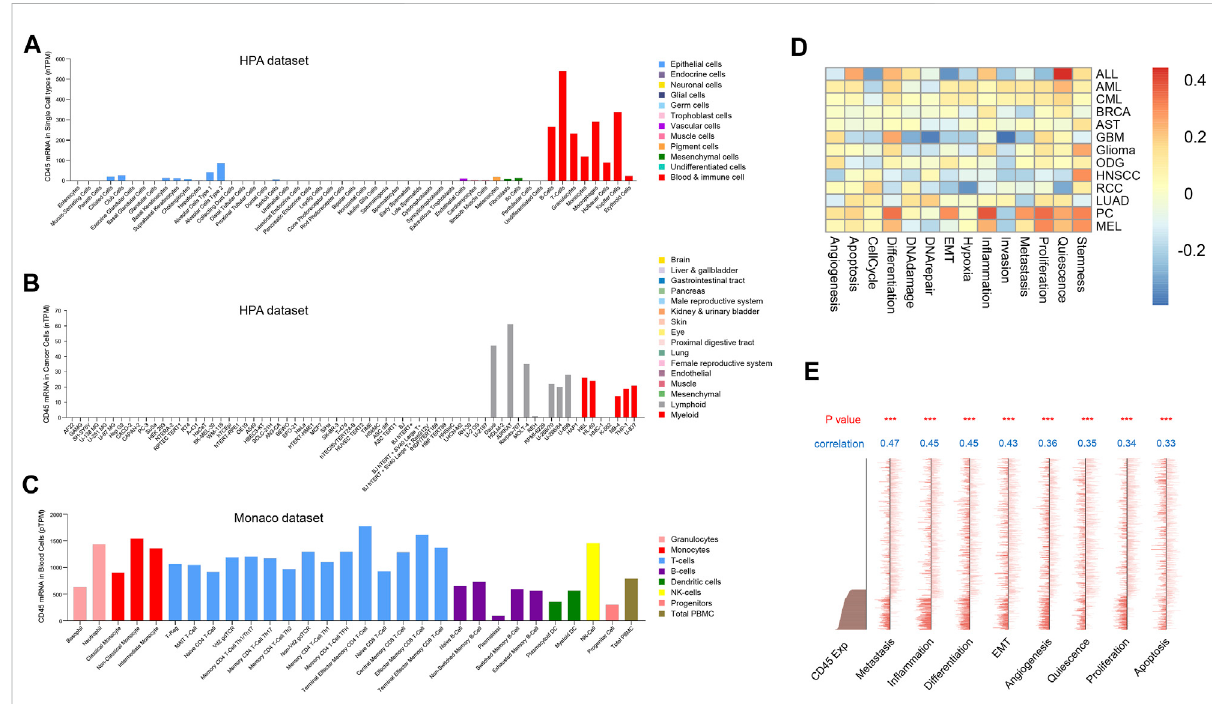
FIGURE 2 Analysis ofCD45 expressionatthe cellular level. Analysis of CD45 expressioninnormalcells (A) , cancer cells (B) and immune cells (C) basedon transcriptome data. (D) Analysis of correlation between CD45 expression and the occurrence of multiple cellular processes in different cancers based on single-cell sequencing data in CancerSEA. (E) Analysis of correlation between CD45 expression and the occurrence of multiple cellular processes in AML (EXP0047) based on single-cell sequencing data in CancerSEA. * p < 0.05; ** p < 0.01 and *** p <